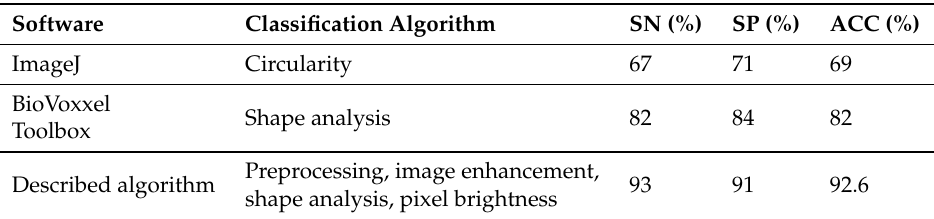
Table 1. Comparison of classification results for different algorithms. ACC: accuracy; SN: sensitivity; SP: